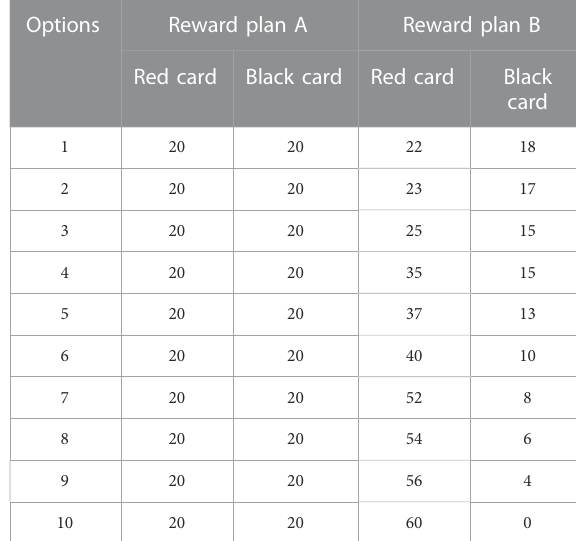
TABLE 2 Formal test, unit: yuan. Options